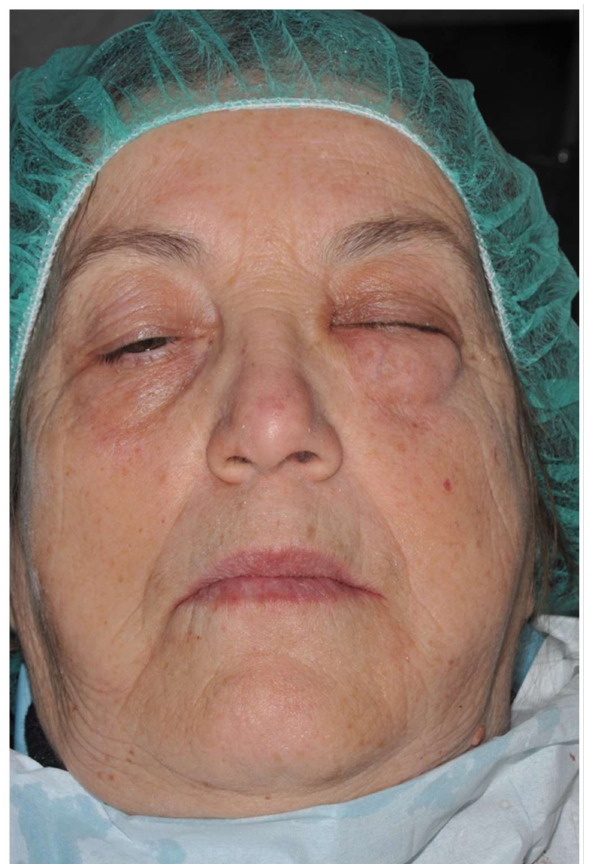
Figure 4. Extra-oral image immediately after air-powder abrasive debridement: unilateral facial swelling in the left cheek and periorbital area with the inability to open the left